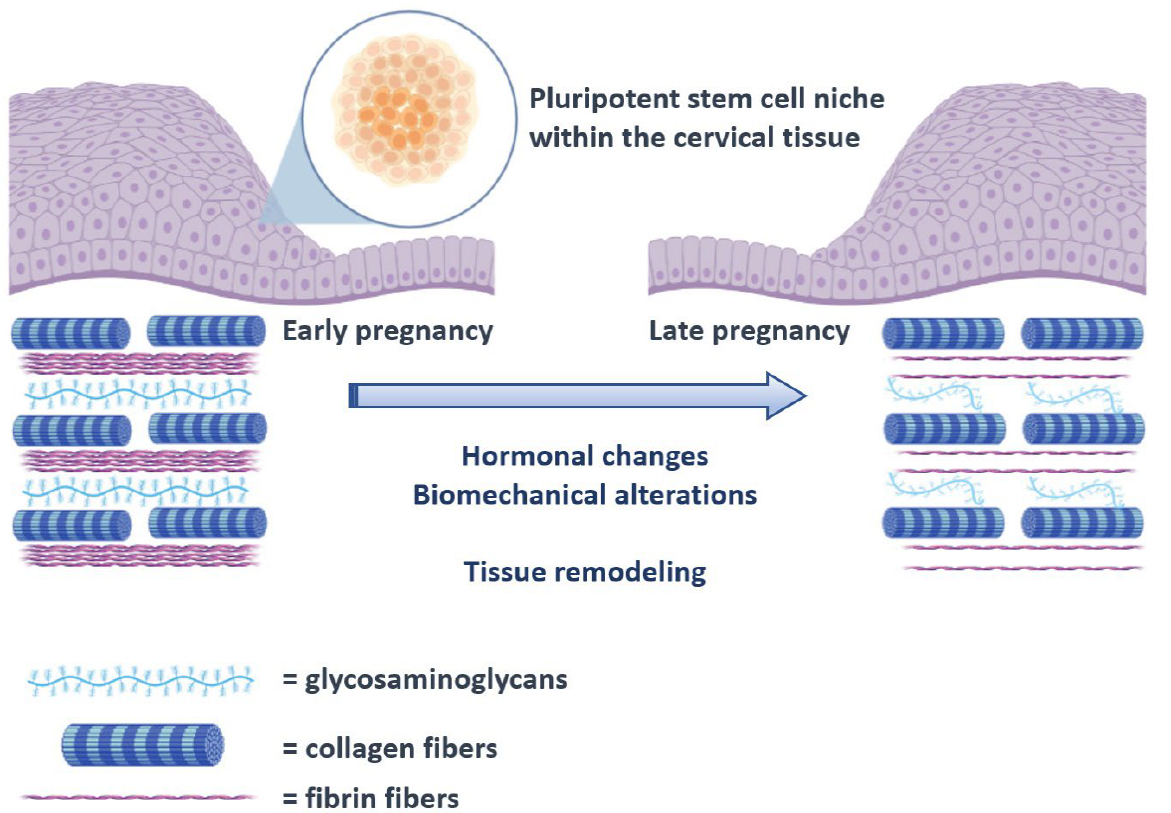
Figure 1. Schematic representation of the proposed process of cervical remodeling during pregnancy, under the influence of stem cells. The hormonal changes and biomechanical alterations that are observed as the pregnancy course progresses are thought to exert a proinflammatory state that progressively triggers cervical tissue remodeling that will ultimately result in cervical ripening. The process is already known to involve several cytokines including interleukins and the tissue necrosis factor a (TNF-a) [4,5]. In the present schematic representation, activation of the pluripotent cervical stem cell niche is proposed to interact with these factors and direct tissue remodeling.